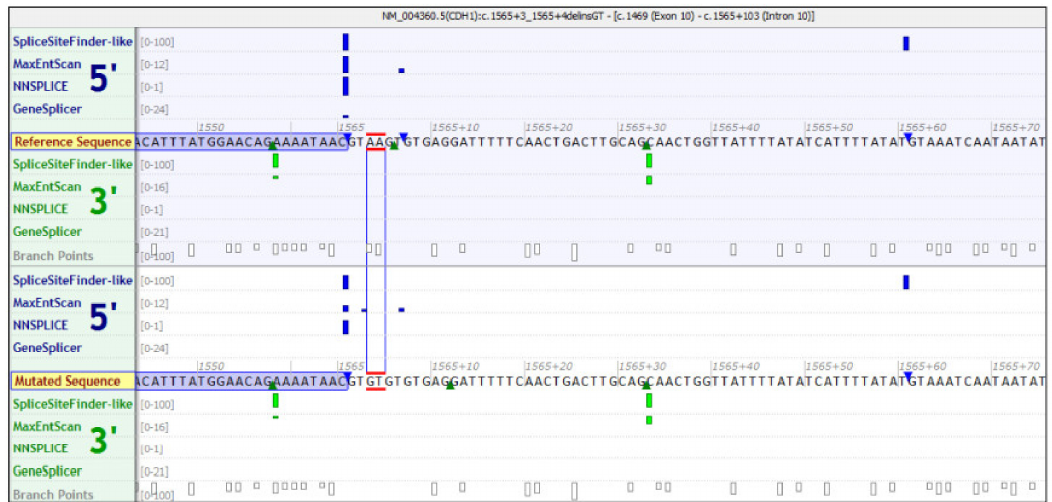
Figure 2. Indel c.1565 + 3_1565 + 4delinsGT effect for the index case JI-014, as shown by Alamut Visual Interactive Biosoftware covering several in silico prediction tools, such as Splice Site Finder-like, MaxEntScan, NNSPLICE, and